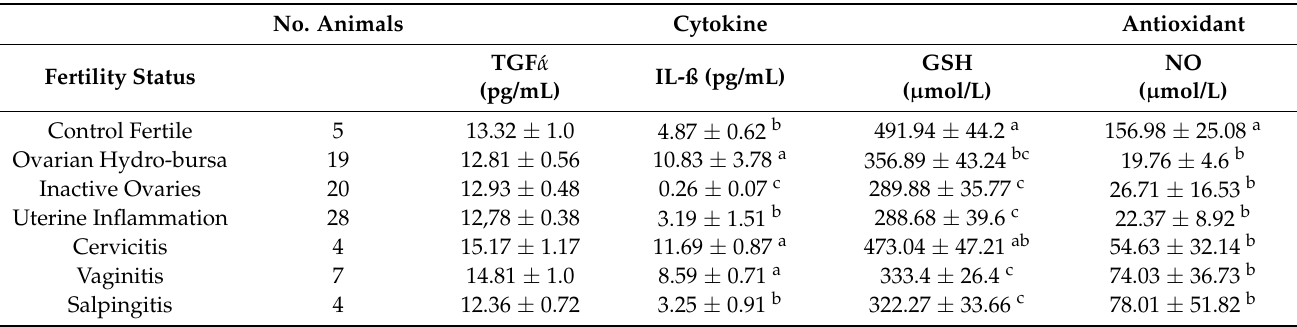
Table 3. Effect of the fertility status of the female dromedary camel on cytokines and antioxidants (Mean ±